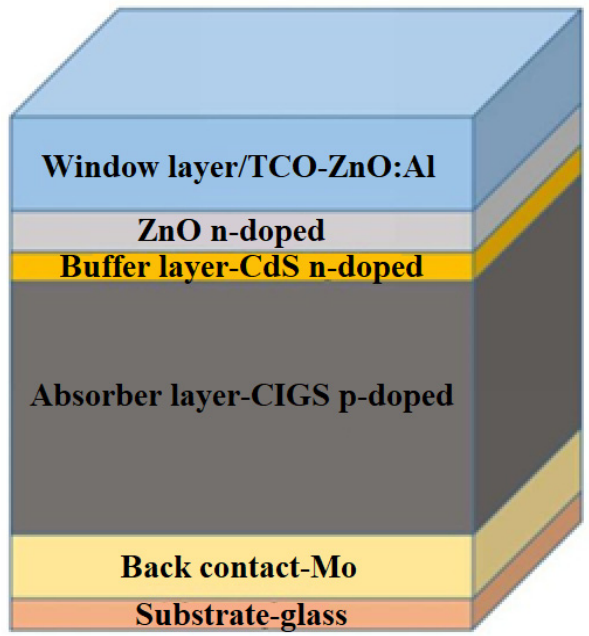
Figure 10. Demonstration of the CIGS-based standard solar cell stack